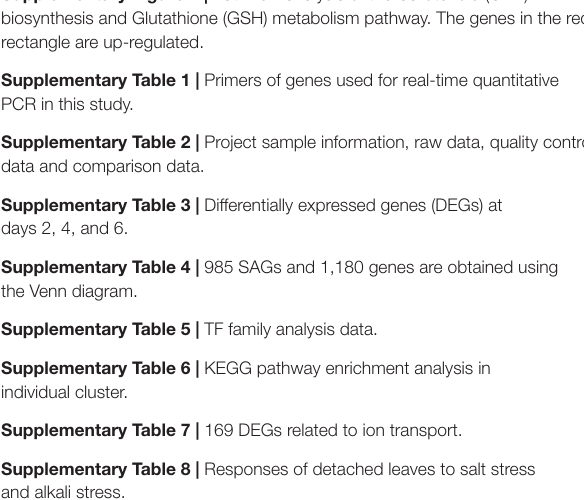
Supplementary Figure 1 | Correlation analysis showed the direct association between samples in the same treatment. Supplementary Figure 2 | Validation of RNA-seq data by the qRT-PCR analysis. Correlation of expression changes observed by RNA-seq ( Y -axis) and qRT-PCR ( X -axis) relative expression levels from log 2 Fold Change of 25 genes in different groups. Supplementary Figure 3 | Data visualization according to cluster analysis. The horizontal coordinates represent specific samples, the vertical coordinates represent the expression values after treatment log 10 (x + 1) and the different colored lines represent the trend of different genes in all samples. Supplementary Figure 4 | Pathview analysis of the Carotenoid (CAR) biosynthesis and Glutathione (GSH) metabolism pathway. The genes in the red rectangle are up-regulated.